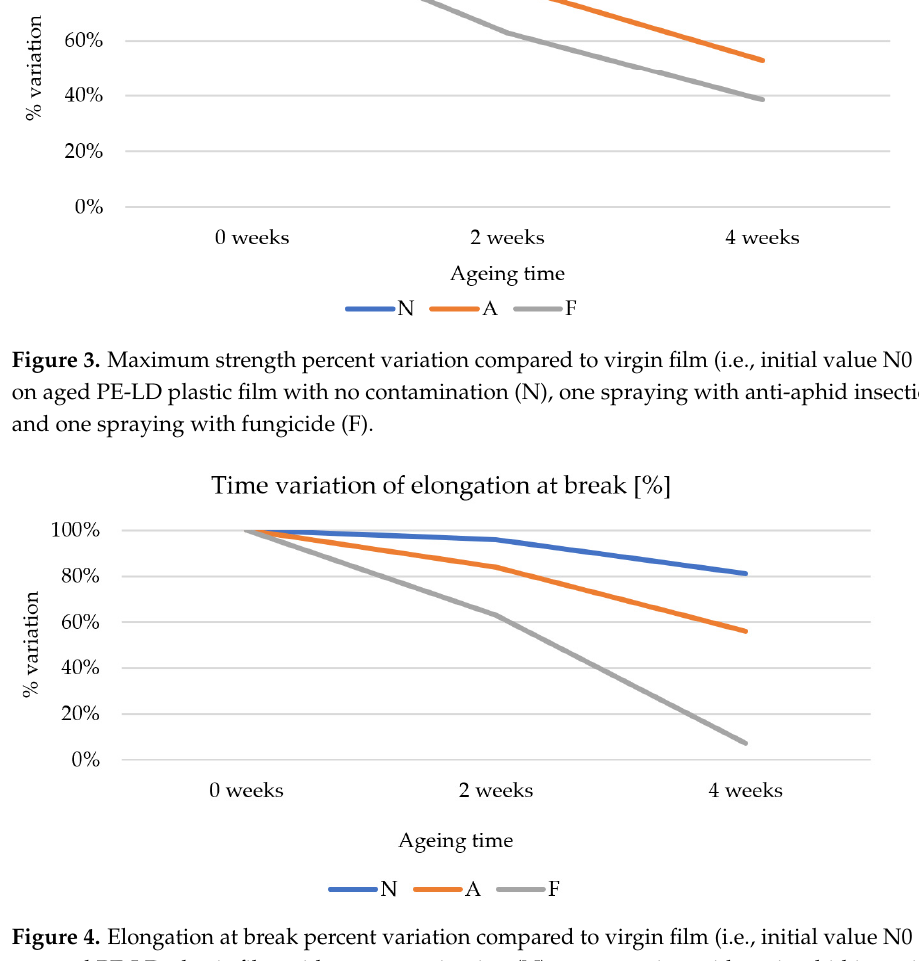
Figure 4. Elongation at break percent variation compared to virgin film (i.e., initial value N0 = 100%) on aged PE-LD plastic film with no contamination (N), one spraying with anti-aphid insecticide (A) and one spraying with fungicide (F).